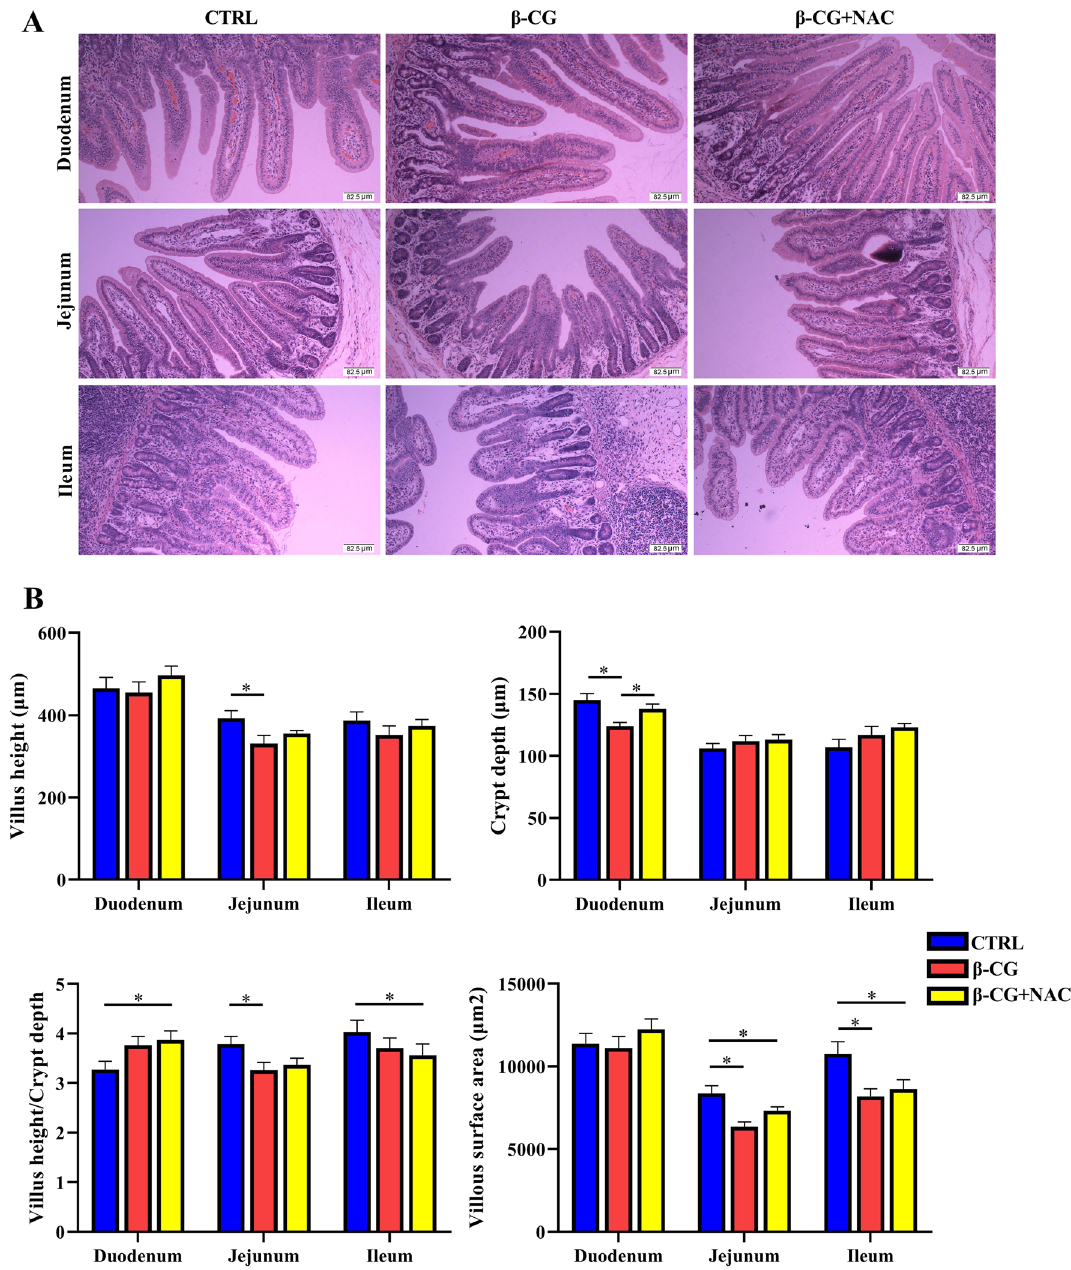
Figure 4. Intestinal morphology in piglets. ( A ) Sections of intestinal segments were stained with haematoxylin and eosin (× 100). ( B ) Villus height is defined as the distance from the villus tip to crypt mouth, and crypt depth is the depth of the distance from the crypt mouth to the base, and villus width is the width at half of villus height. Villous surface area (VSA) was calculated according to the equation: VSA = 2πrh (r = villus width/2, h = villus height). Data are means ± SEM, n = 8. * P <